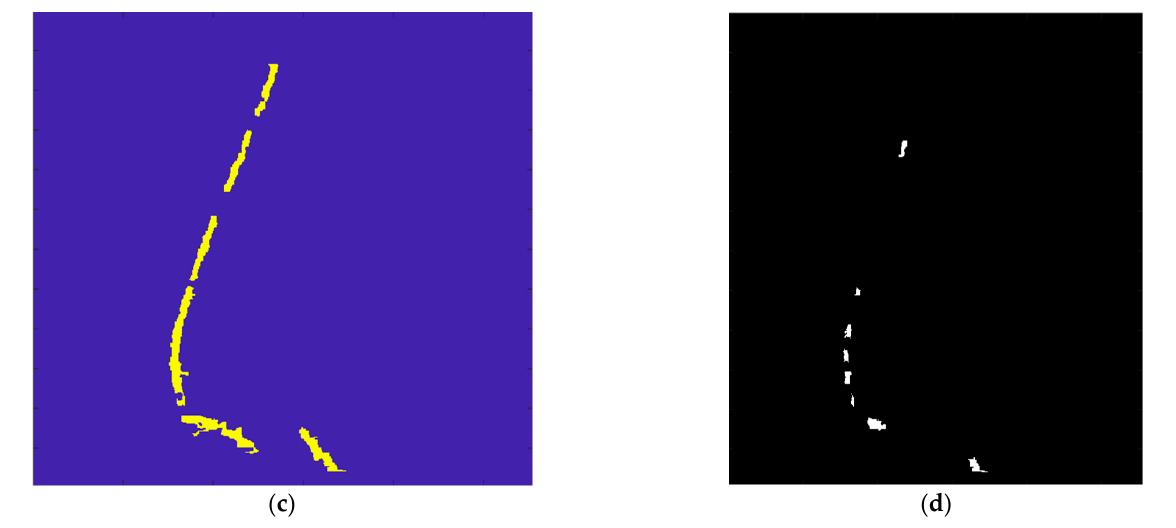
Figure 8. Frame 89 detection results: ( a ) video SAR image; ( b ) foreground image; ( c ) motion track; ( d ) final detection result.